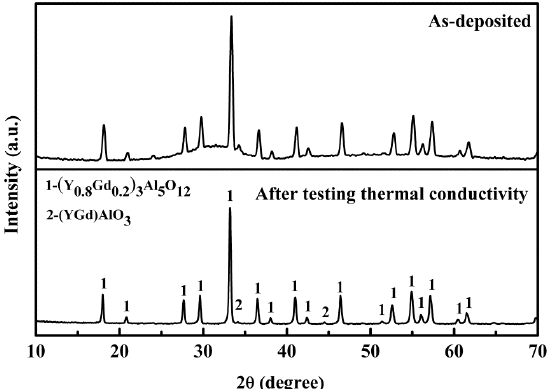
Figure 8. XRD patterns of the GYAG coating before and after thermal conductivity measurements.